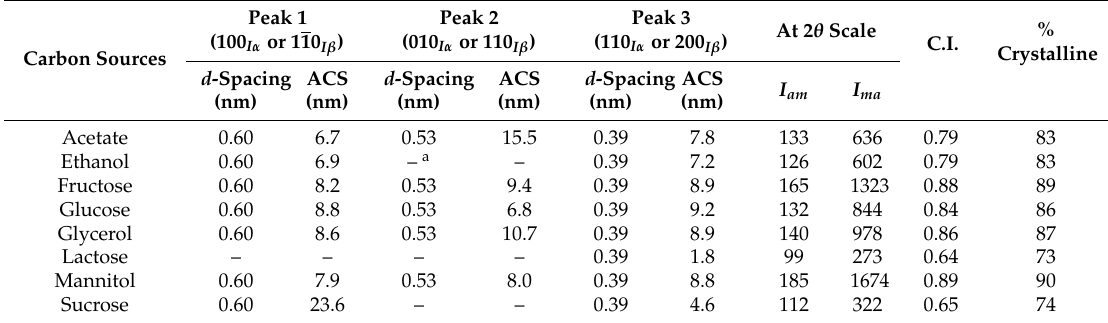
Table 2. D -spacing, apparent crystal size (ACS), crystallinity index (C.I.). and % crystalline of BC samples produced from different carbon